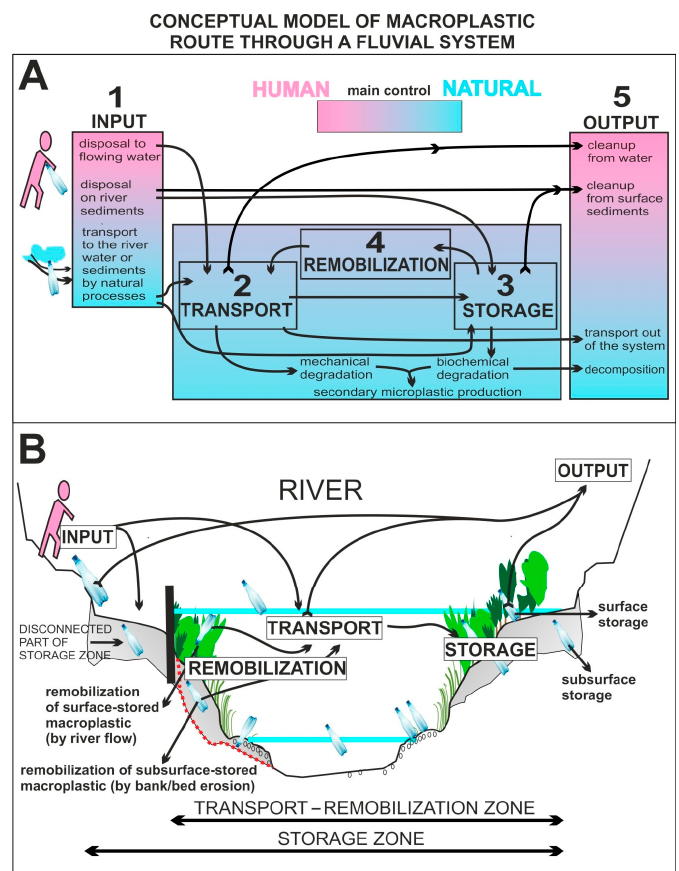
Figure 1. Conceptual model of the route of macroplastic debris through a fluvial system, with indicated sequence of phases ( A ) and their spatial extent in the cross-section of a river valley ( B ).